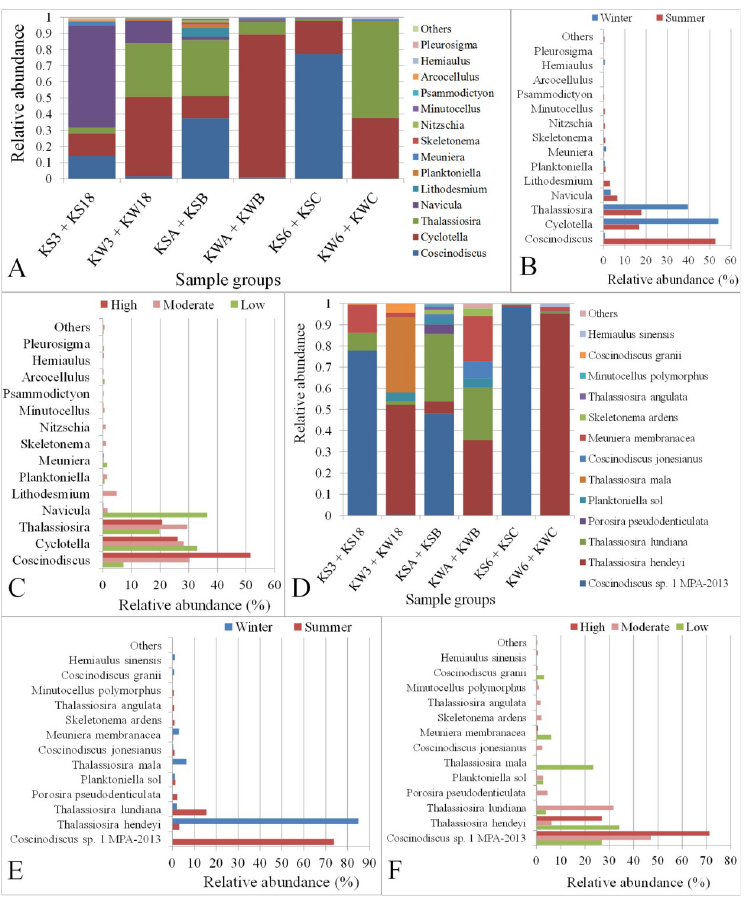
Fig 11. Relative abundance of Diatom genera and species in Kuwait water. A, B and C: Abundances of Diatom genera in samples grouped based on sampling station, season and anthropogenic activity level, respectively. D, E and F: Abundances of Diatom species in samples grouped based on sampling station, season and anthropogenic activity level, respectively. The term “Others” in the Y-axis includes genera or species with an abundance of < 0.1%. KS3 + KS18: Samples collected in summer from stations with low anthropogenic activity levels; KW3 + KW18: Samples collected in winter from stations with low anthropogenic activity levels; KSA + KSB: Samples collected in summer from stations with moderate anthropogenic activity levels; KWA + KWB: Samples collected in winter from stations with moderate anthropogenic activity levels KS6 + KSC: Samples collected in summer from stations with high anthropogenic activity levels; KW6 + KWC: Samples collected in winter from stations with high anthropogenic activity